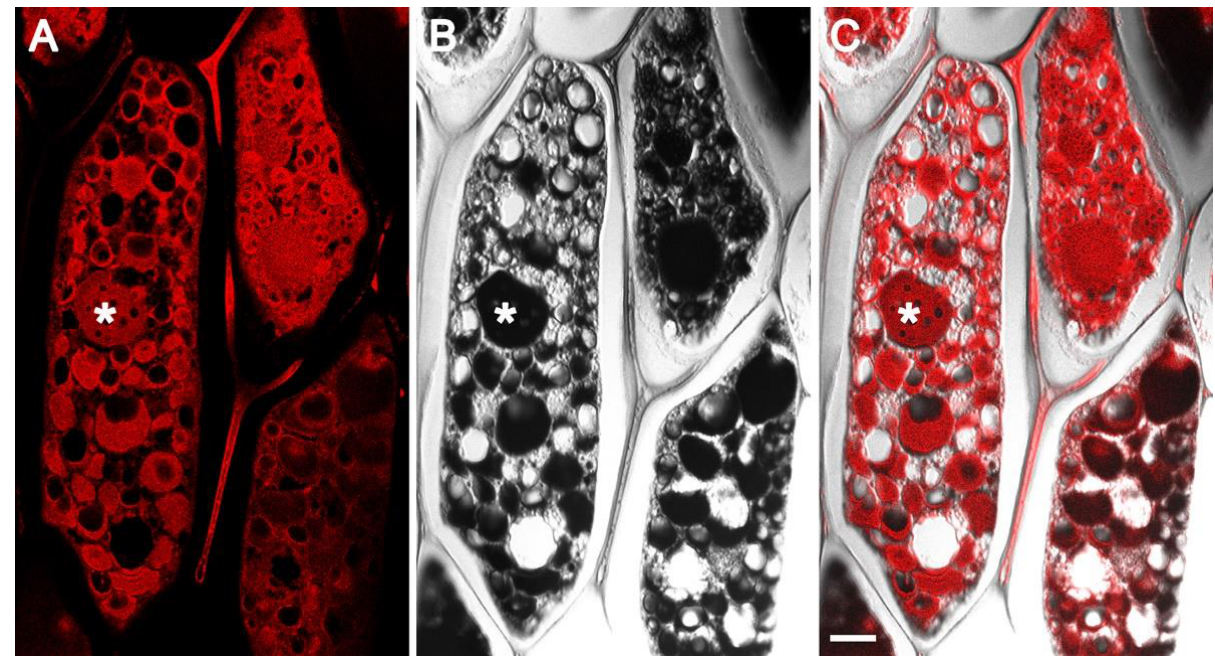
Figure 2. Confocal images of FAA-fixed, paraffin-embedded sections of the mature soybean cotyledon stained with eosin. Confocal single optical slice ( A ), DIC image ( B ), and DIC and single optical slice overlay ( C ). Asterisk indicates protein storage vacuole. Scale bar 10 µm.